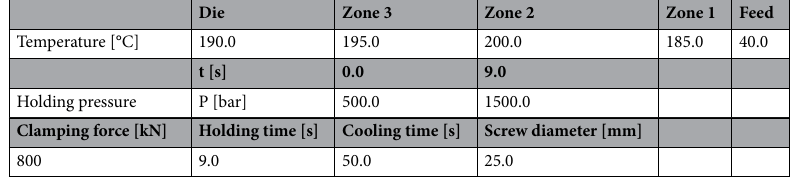
Table 2. Injection parameters.